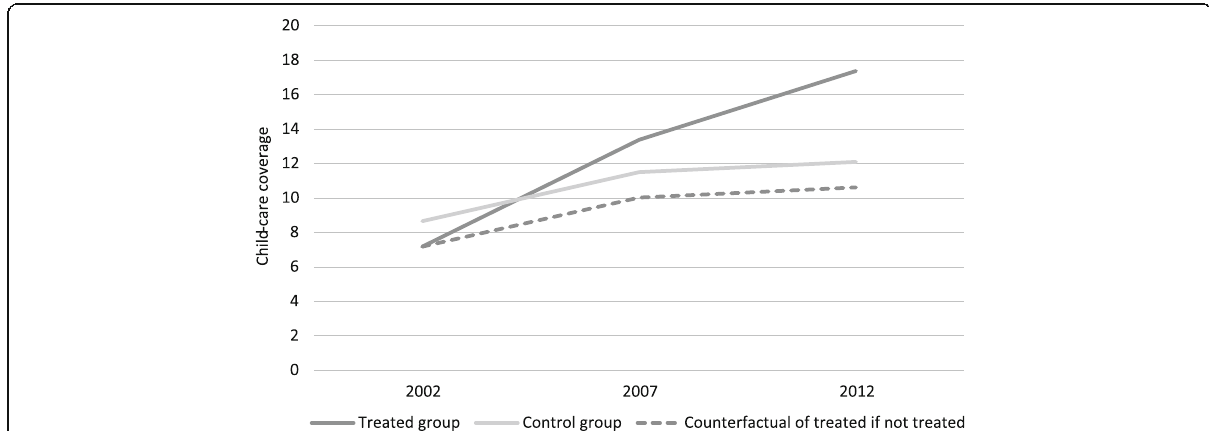
Fig. 1 Evolution of childcare coverage, comparison between treated and control groups. Source: Administrative data on cantonal childcare places (Ravazzini et al. (2016), 2012 cantonal statistics for Bern, Neuchâtel and Vaud). The dotted line highlights the expected behaviour of the treated group in absence of treatment. A linear trend is assumed to interpolate the missing years